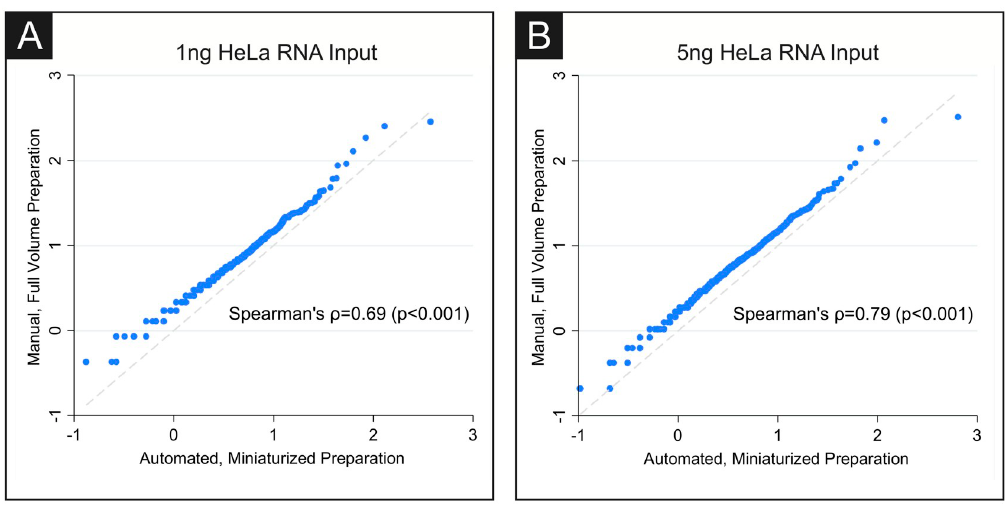
Fig 5. HeLa transcriptome coverage is comparable in full volume and miniaturized volume preparations. Rank-rank plots of the human transcriptome show strong correlation between the full-volume hand prepared protocol and the miniaturized, automated protocol for both (A) 1ng and (B) 5ng of HeLa RNA input (5ng RNA input: Spearman’s ρ = 0.79, p < 0.001; 1ng RNA input: Spearman’s ρ = 0.69, p <